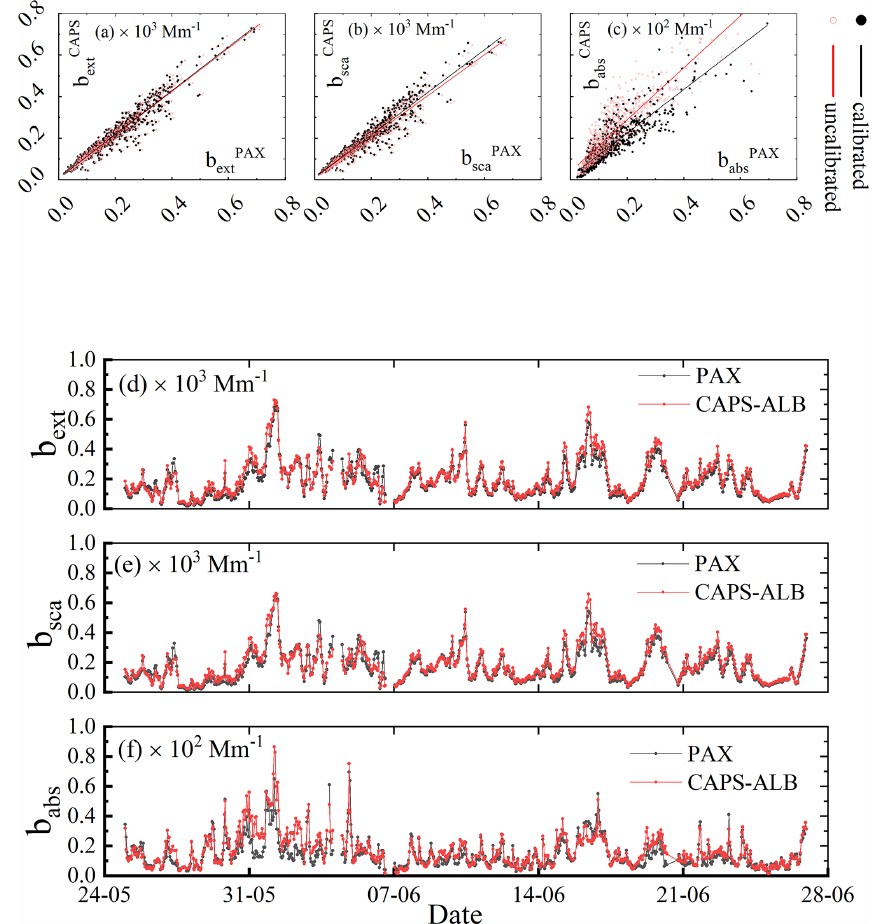
Figure 5. Intercomparison of the CAPS-ALB and PAX (in the case of calibrated and uncalibrated) for (a) extinction, (b) scattering and (c) absorption coefficients during field measurement (From 25 May to 27 June), and the timing diagram of the calibrated (d) extinction, (e) scattering and (f) absorption coefficients of CAPS-ALB and